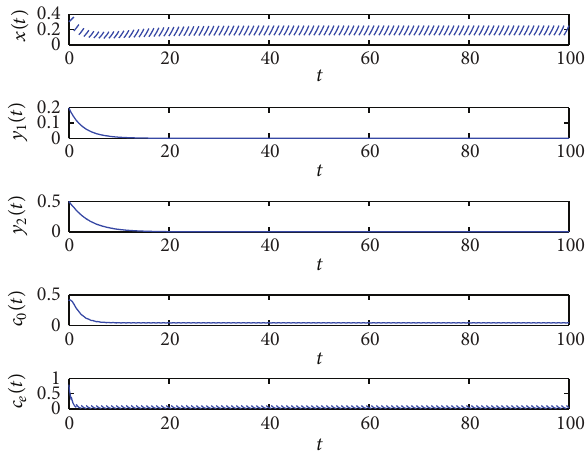
Figure 2: Time series of system (2) with parameters 𝛽 = 0.9 , 𝐾 = 0.8 , 𝑞 = 0.8 , 𝑑 = 0.4 , 𝜏 = 0.5 , 𝜆 = 0.8 , 𝛾 = 0.3 , 𝑏 = 0.1 , 𝑘 = = 0.2 , 𝑓 = 0.1 , 𝛿 = 0.1 , 𝛼 = 0.2 , ℎ = 2 , 𝑔 = 0.2 , 𝑚 = 0.4 , 0.5 , 𝑓 2 1 and 𝑇 = 0.3 .